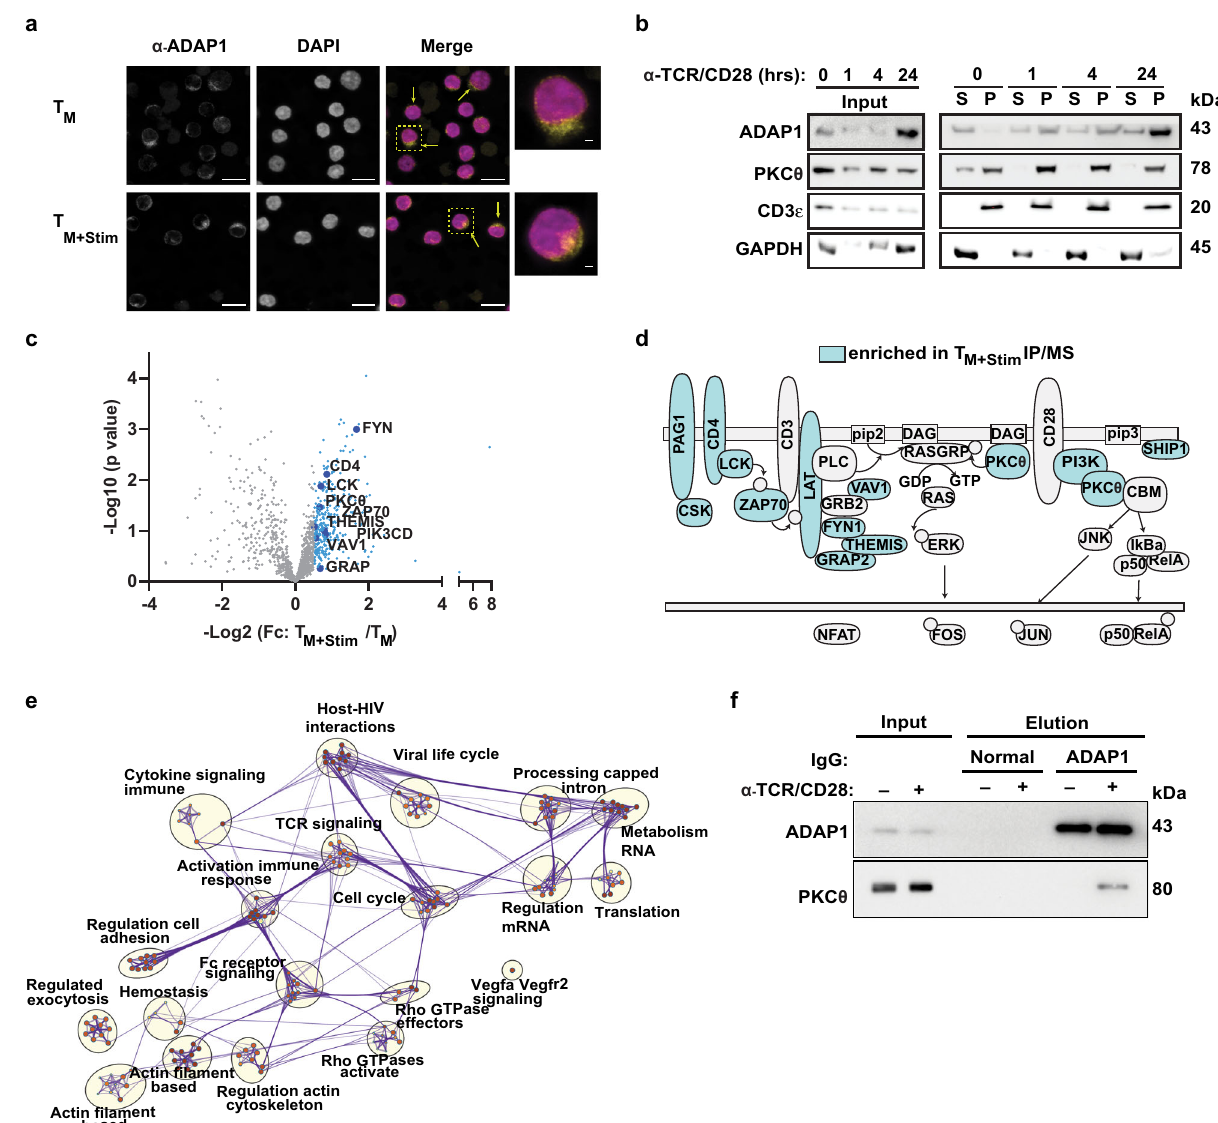
Fig. 4 ADAP1 interacts with the immune signalosome. a Representative immuno fl uorescence probing ADAP1 localization in unstimulated and stimulated (4 h TCR/CD28) T M . Repeated in 1 other donors with similar results. Scale bar is 10 μ m for multicell images and 1 μ m for single cell images. b Representative donor ( n = 2) western blot analysis of cell fractionation assay. Resting (0 h) or stimulated T M (1 h, 4 h, 24 h) were fractioned into “ S ” supernatant (cytosolic) or “ P ” pellet (membrane) fraction. c Resting T M and stimulated (1 h) T M of one donor were immunoprecipitated in triplicate with ADAP1 antibody and submitted for tandem mass spectrometry analysis. Volcano plot represents average Log 2 Fc of factor enrichment in stimulated T M over resting T M . Samples with Log 2 Fc > 0.5 are highlighted in blue. A sample of immune signalosome proteins are highlighted. See Supplementary Data 1 for complete list of interacting partners, semi-quantitative abundance and statistical signi fi cance. d Visual representation of second donor mass spectrometry results of T M stimulated for 1 h and immunoprecipitated with IgG or ADAP1 antibodies. See Supplementary Data 2 for complete list of interacting partners, semi-quantitative abundance. Interacting proteins that form part of the immune signalosome or T cell membrane are highlighted in blue. e Protein – protein interacting network analysis clustered by gene ontology. Nodes are color-coded and size-coded based on p value. Edges (purple lines) represent network connections. Gene ontology category derived from Metascape analysis are written next to clusters. f Representative western